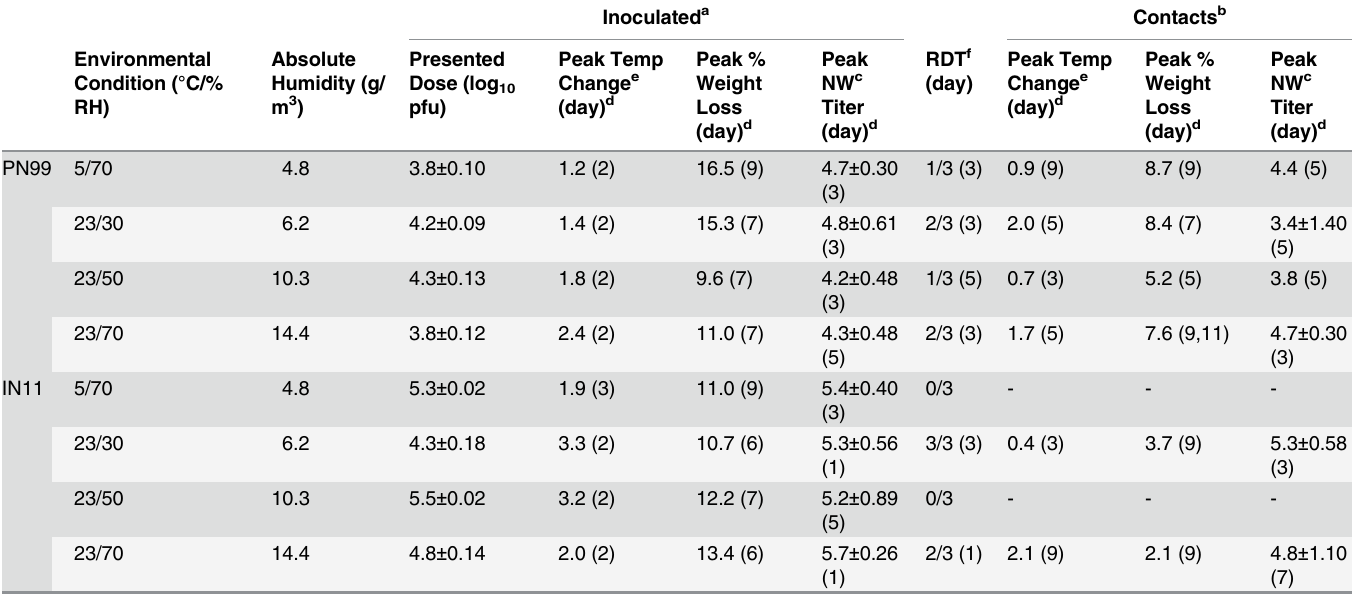
a Data shown represent the mean of 3 inoculated animals. b Data shown represent infected, contact animals only. ± SD is shown. c NW, Nasal wash titer (log 10 pfu/mL) d Day post inoculation or post contact the peak was observed is shown in parentheses. e Temperature change over baseline (35.7 – 39.6°C) is shown. f RDT, Respiratory droplet transmission frequency and the day post-exposure that virus was fi rst detected in contact animals is shown in